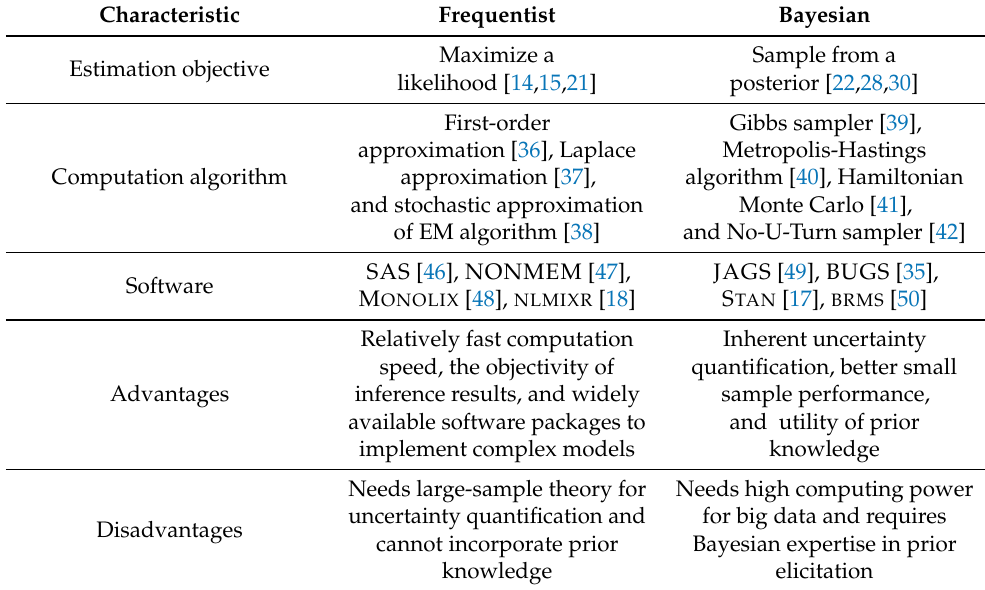
Table 1. Comparison of modeling strategies used in frequentist and Bayesian approaches for the nonlinear mixed effects models from an implementational